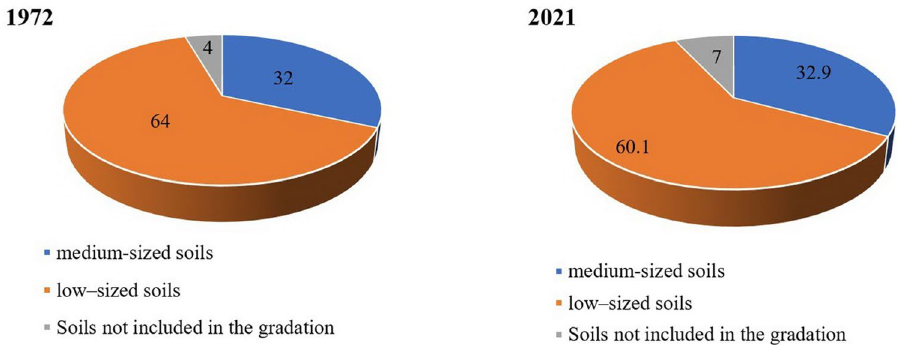
Figure 2. Distribution of soils by humus horizon thickness by region.